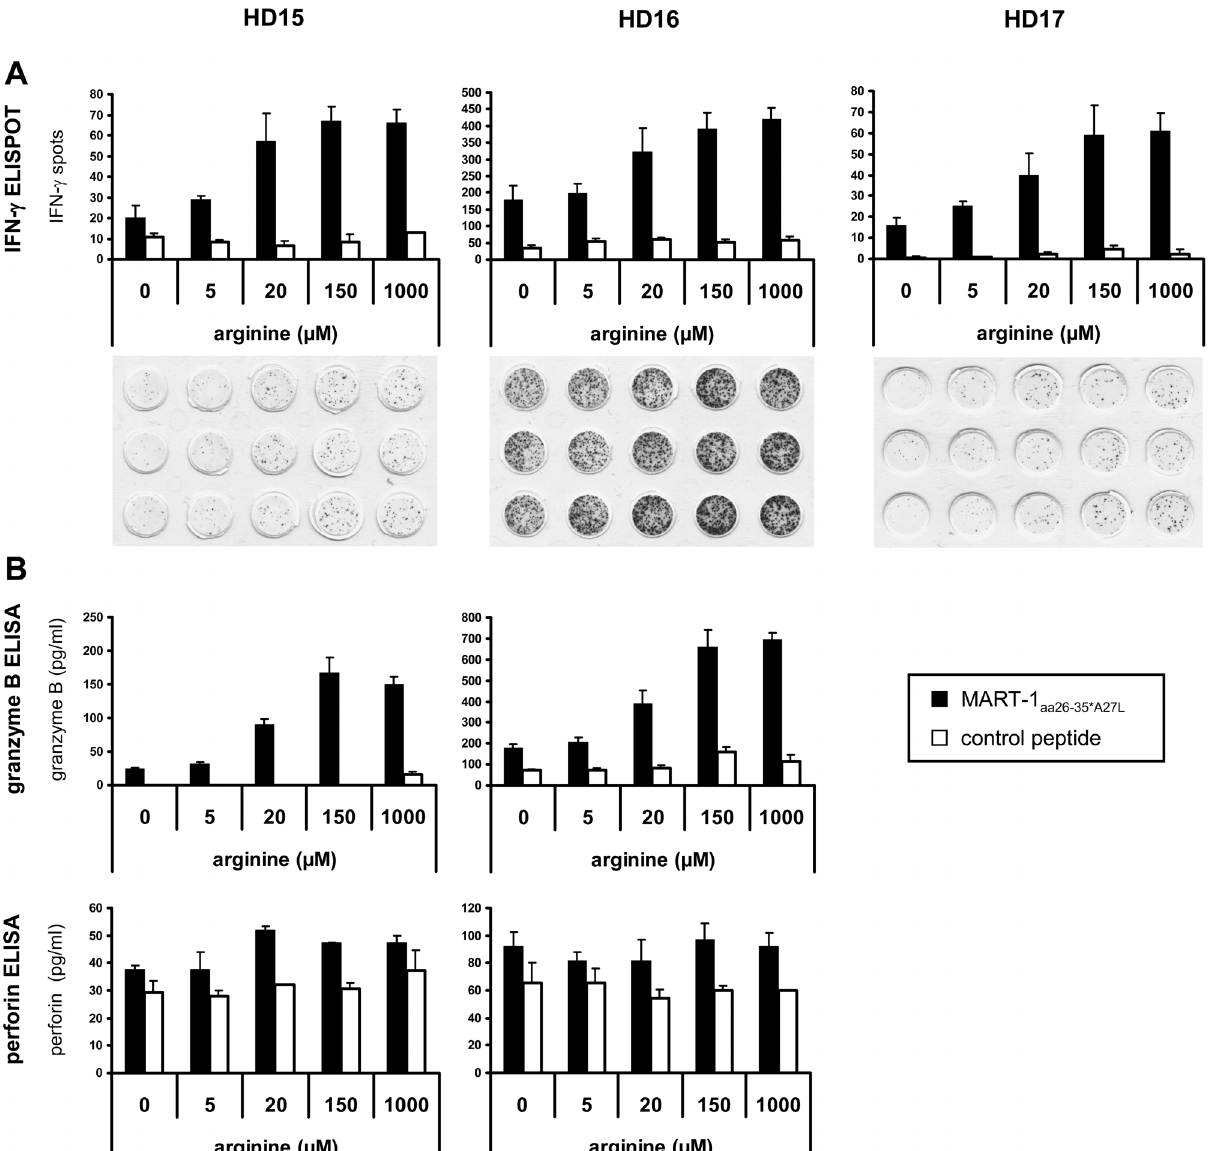
Figure 4. Tumor antigen specific secretion of IFN- c and granzyme B by human CD8 + T cells is regulated by the extracellular arginine concentration, whereas perforin secretion is independent of arginine. Expanded MART-1 aa26–35*A27L specific CD8 + T cells of 3 HD were activated with MART-1 aa26–35*A27L peptide (black bars) or control peptide (white bars) loaded T2 cells in medium with different concentrations of arginine (0, 5, 20, 150 and 1000 m M) in ELISPOT assays. After 24 h supernatants were harvested to determine granzyme B/perforin release by ELISA and IFN- c was detected on ELISPOT membranes. A Results of ELISPOT assays are shown as mean of triplicates. The corresponding ELISPOT membranes of activation with MART-1 aa26–35*A27L peptide loaded T2 cells are shown below the diagrams. B Granzyme B/perforin concentration in supernatants of ELISPOT assays of 2 HD determined by ELISA.